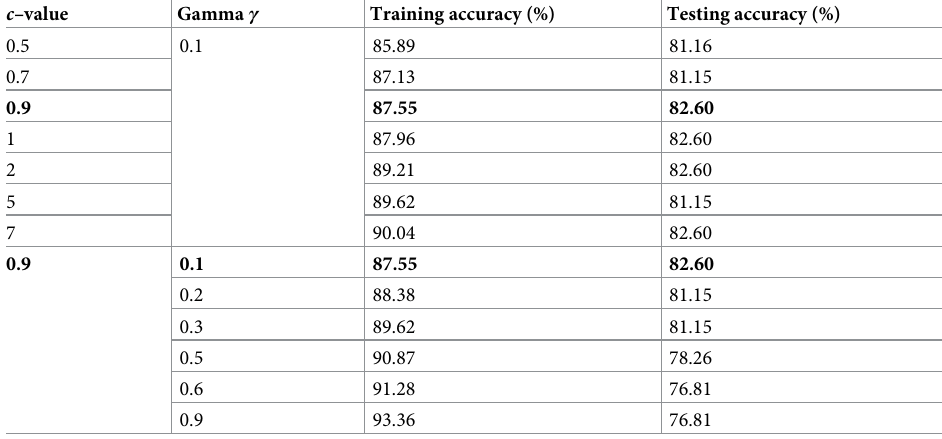
Table 4. SVM with RBF kernel using 6